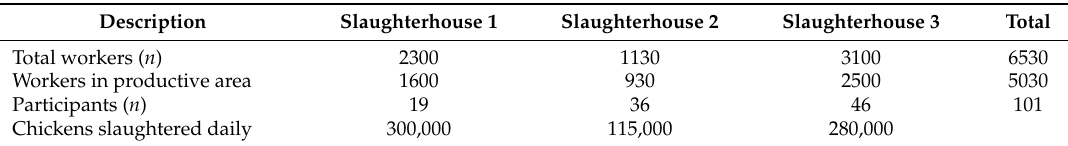
Table 1. Work organizational characteristics in